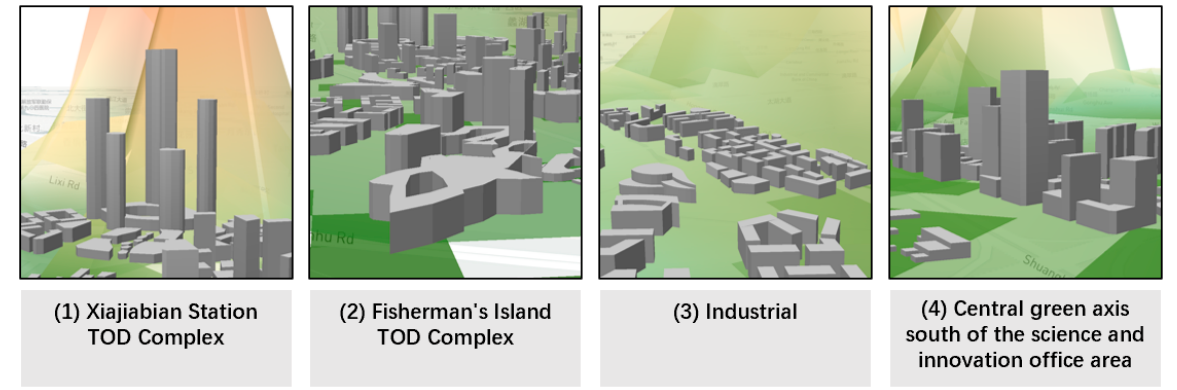
Figure 8. Carbon emission and carbon sink distribution of Lihu Future City design scheme (Visual- ization based on mapbox platform).